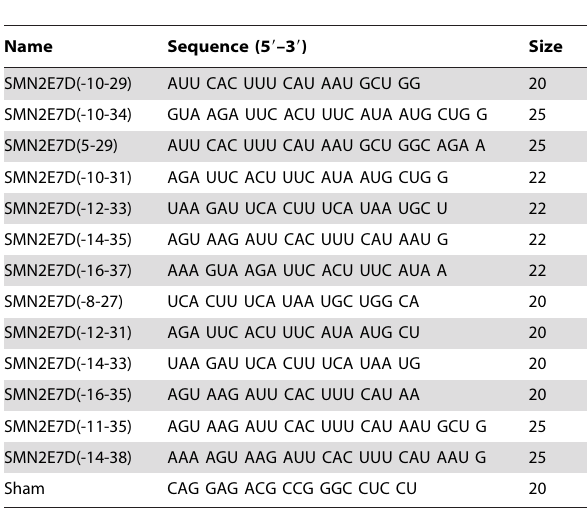
Table 1. The list of the 14 PMOs examined in this